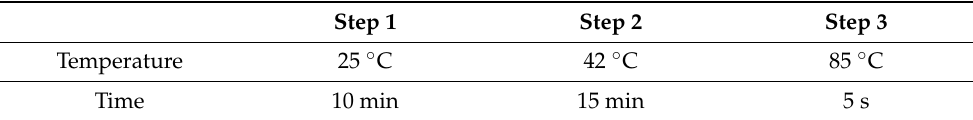
Table 1. Steps of the thermal cycles for cDNA reverse transcriptions.